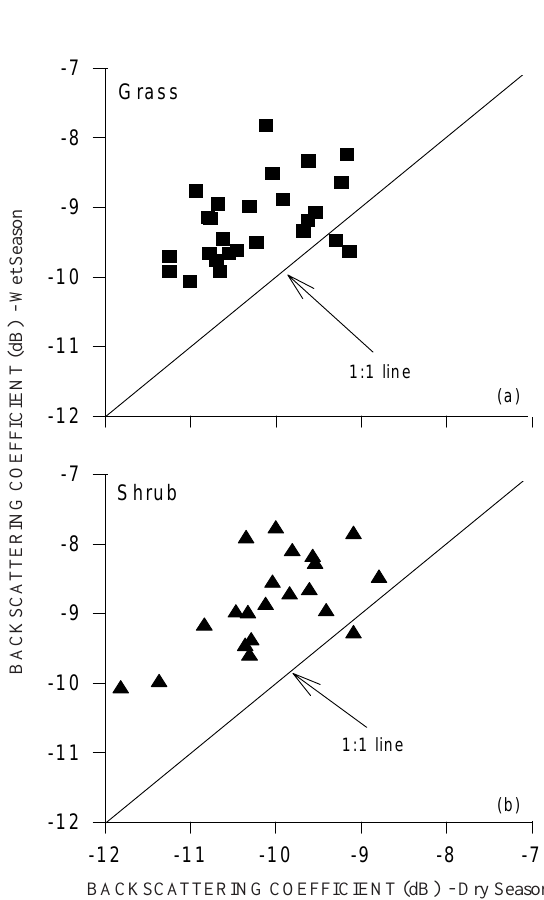
Figure 5. Relation between 1994 wet season SAR image and 1992 dry season SAR image for (a) grass-dominated and (b) shrub-dominated sites.